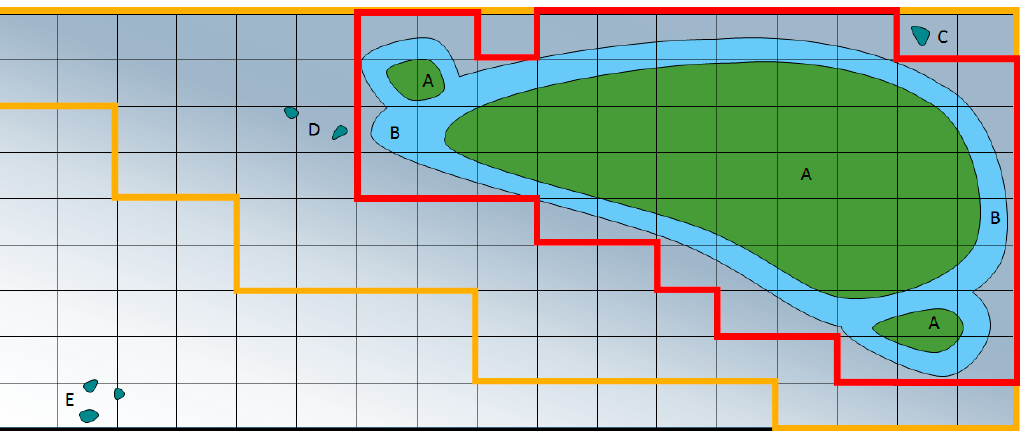
Figure 2. Diagrammatic representation of using a within-field spatial weed model for patch spraying.